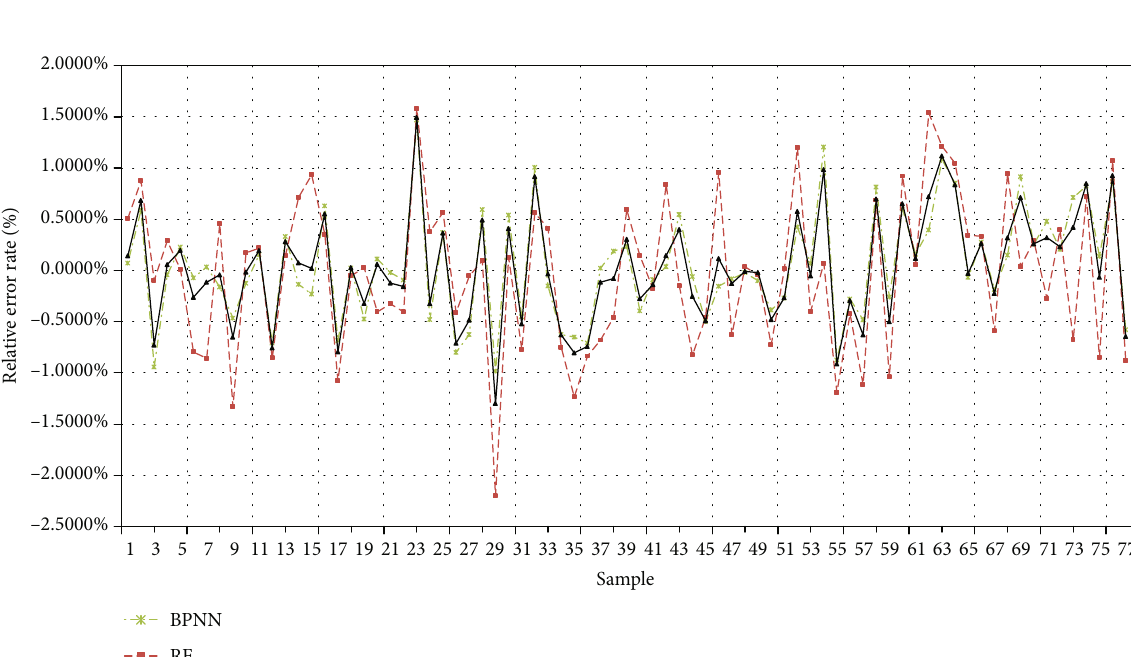
Figure 5: Relative error rate curves of HL predicted by each model.